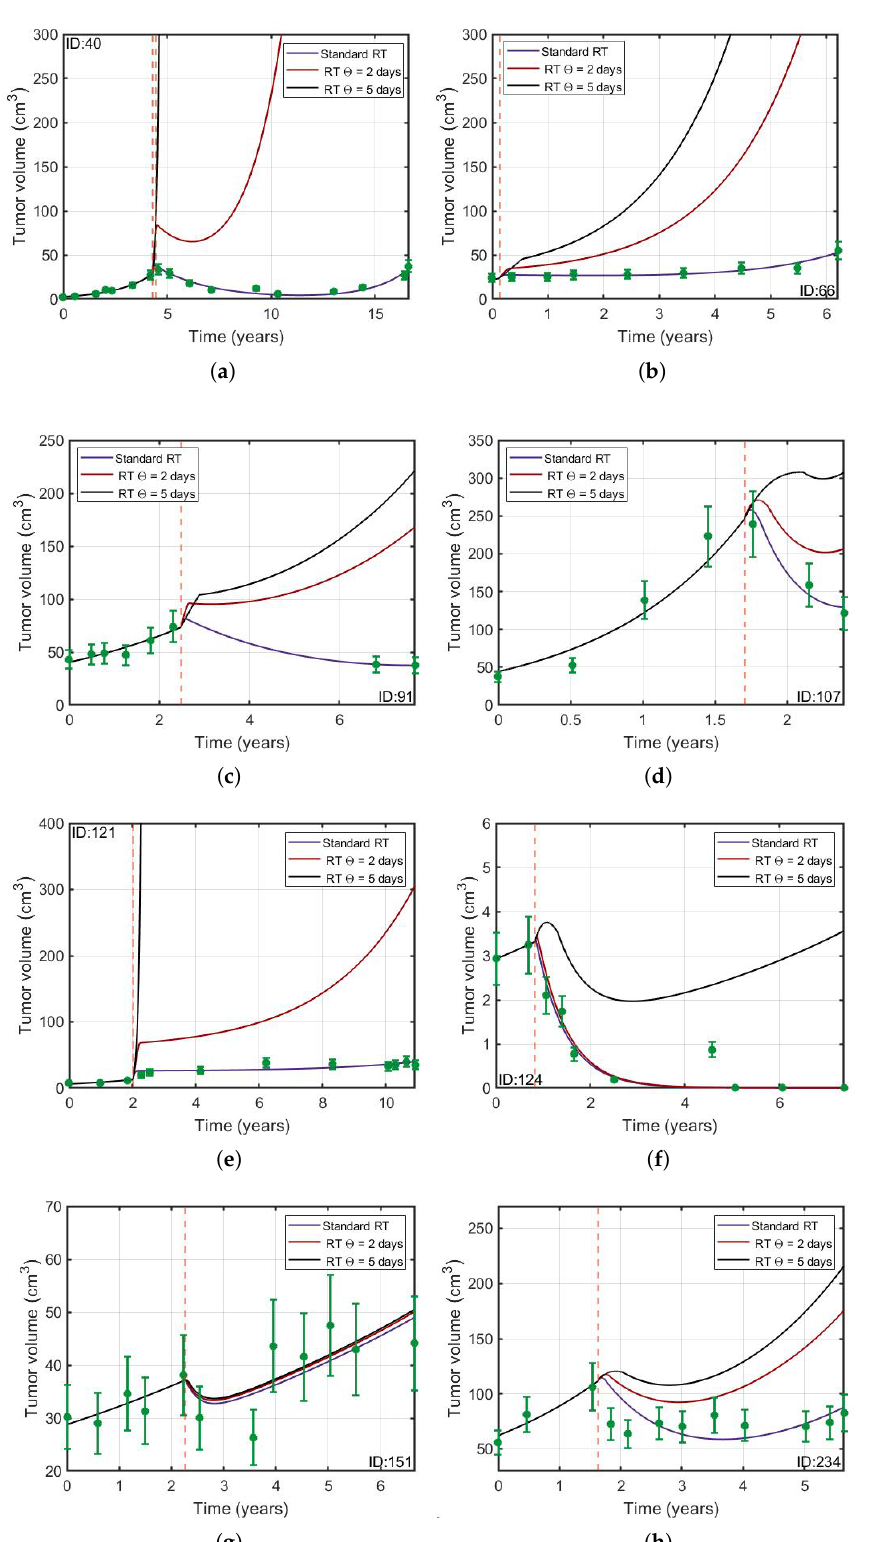
( h ) Figure 5. ( a – h ) Protracted radiotherapy schemes lead to increased tumor growth in silico. Simulations of longitudinal tumor growth dynamics of patients receiving radiation therapy fractionations spaced at 5 days (black solid line), 2 days (red solid line) and the conventional scheme (purple solid line). The vertical red dashed line shows the treatment start time and the green circles the longitudinal volumetric